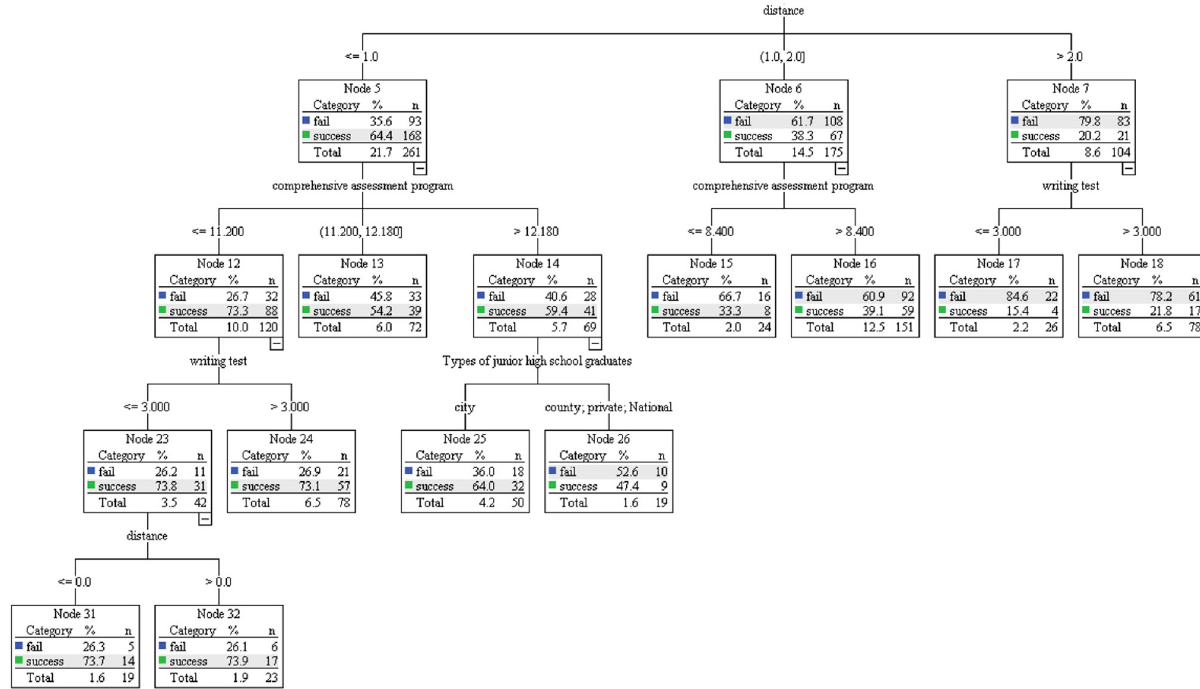
Fig. 8 A sub-tree on right for the training. A sub-tree structure for the test sample in the agricultural county